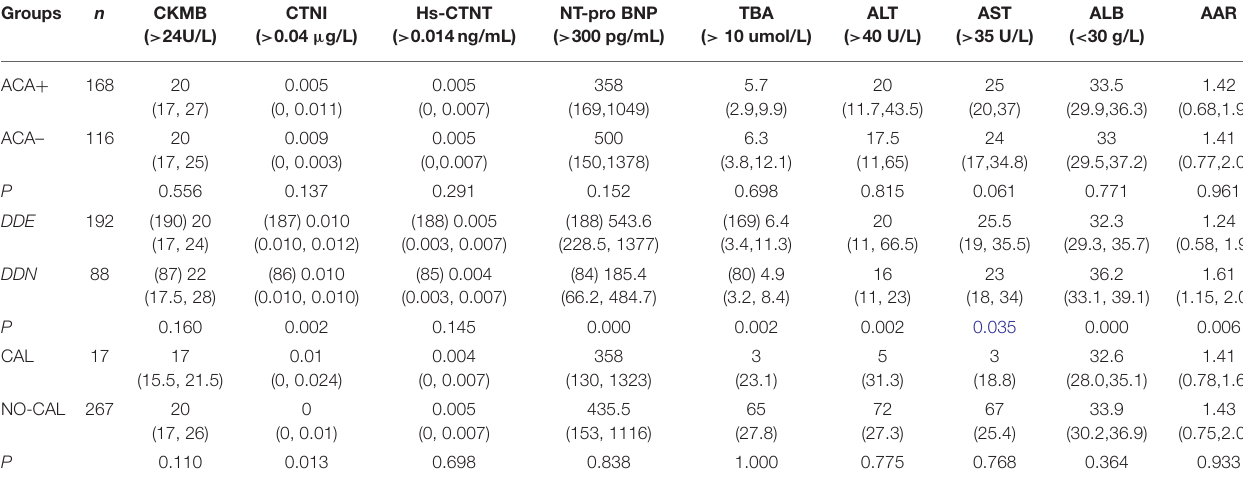
TABLE 2 | The correlation between ACA/D-dimer and myocardial/liver damage in KD/IKD children. Groups